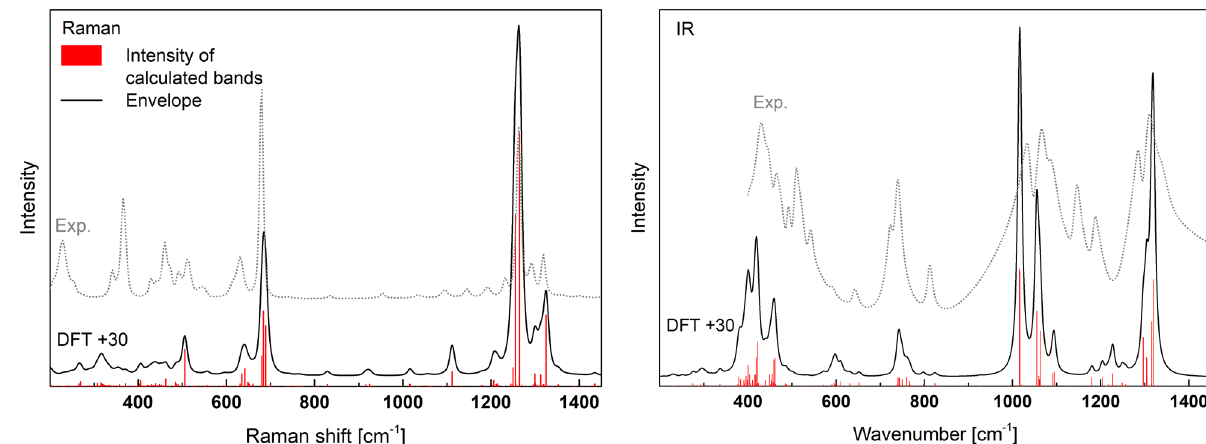
Figure 7. Calculated Raman and IR spectra of A-Al(PO 3 ) 3 shifted by + 30 cm −1 and experimental IR and Raman spectra (Exp.) of the synthesized